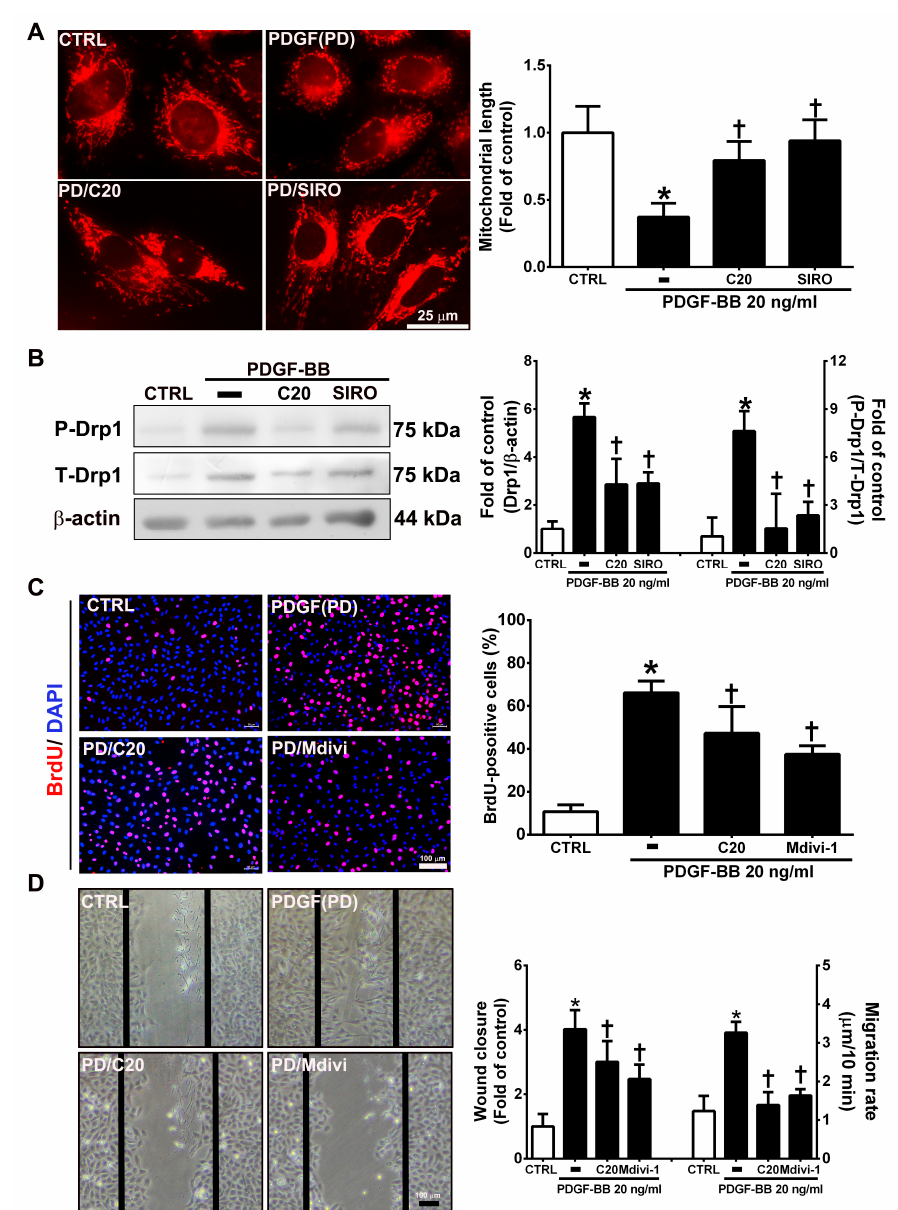
Figure 7. Corylin inhibited mitochondrial fission in VSMCs induced by PDGF-BB through the mammalian target of rapamycin (mTOR) / dynamin-1-like protein 1 (Drp1) pathway. ( A ) Serum-starved VSMCs were pretreated (1 h) with 20 µ M corylin (C20) or 5 nM sirolimus (SIRO; an mTOR inhibitor) and then treated with 20 ng / mL PDGF-BB for 6 h. Fluorescence imaging of mitochondrial morphology was observed with MitoTracker dye. Representative photographs are shown in the left panel, and the quantitative data are shown in the right panel. Scale bars = 25 µ m. ( B ) Serum-starved VSMCs were pretreated (1 h) with 20 µ M corylin or 5 nM sirolimus and then treated with 20 ng / mL PDGF-BB for 24 h. P-Drp1 and T-Drp1 protein expression was determined by Western blot analysis. β -actin was analyzed in parallel as an internal control for protein loading. Serum-starved VSMCs were pretreated (1 h) with 20 µ M corylin or 10 µ M Mdivi (a specific inhibitor of the mitochondrial fission protein Drp1) and then treated with 20 ng / mL PDGF-BB for 24 h. BrdU incorporation ( C ) and wound healing assays ( D ) were performed to determine VSMC proliferation and migration. Nuclei were labeled with DAPI (blue). The data are the mean ± SD. * p < 0.05 versus the untreated group (CTRL). † p < 0.05 versus the PDGF-BB-treated group. Scale bars = 100 µ